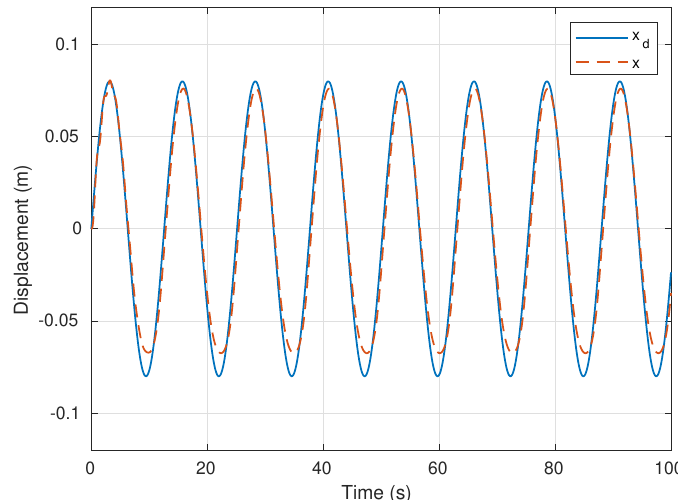
Figure 10. Sinusoidal wave trajectory tracking performance with PID.